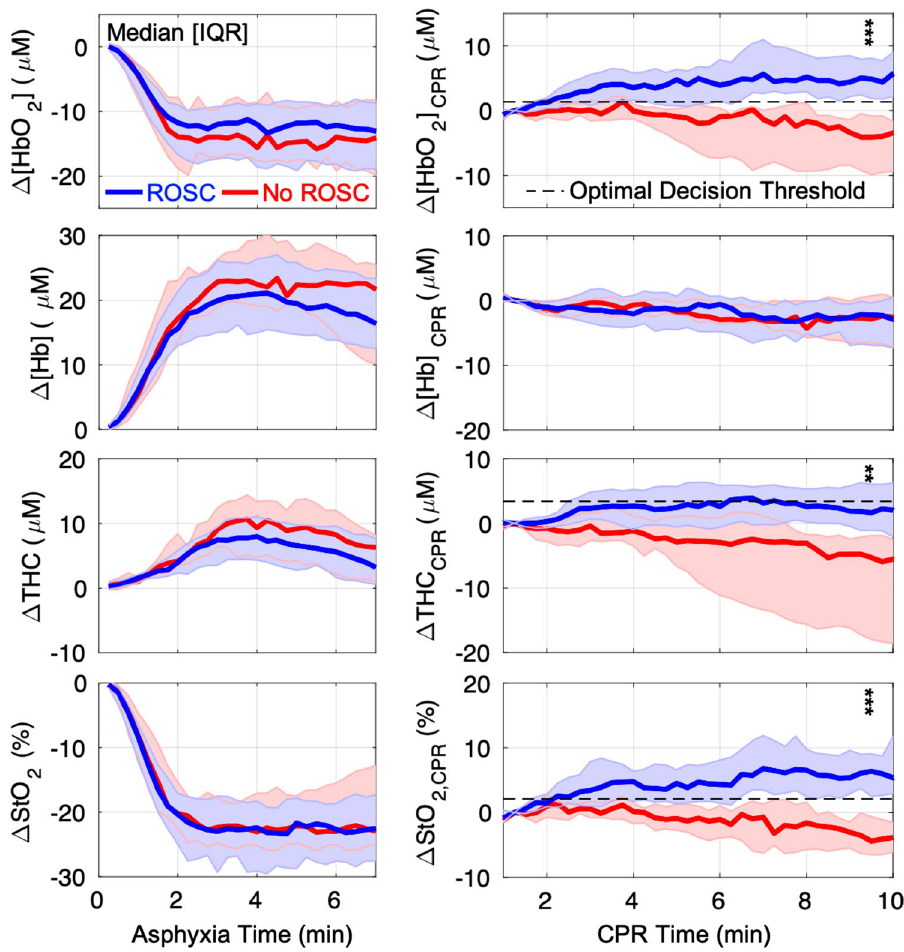
Figure 3. Changes in Cerebral Hemodynamics during Asphyxia and CPR: The changes in cerebral oxy- hemoglobin concentration (Δ[HbO 2 ]; first row ), deoxy-hemoglobin concentration (Δ[Hb]; second row ), total hemoglobin concentration (ΔTHC; third row ) and tissue oxygen saturation (ΔStO 2 ; bottom row ) from baseline during asphyxia ( left ), and from 1-min of CPR during CPR ( right ), are summarized and grouped by CPR outcome (ROSC, blue ; No ROSC, red ). Data are plotted as median ( thick solid line ) and interquartile range (IQR; thin solid line ). The optimal decision threshold for ROSC are also plotted (dotted line) for Δ[HbO 2 ] CPR (+ 1.3 µmol/L), ΔTHC CPR (+ 3.4 µmol/L), and ΔStO 2,CPR (+ 2.1%). In the 10th minute of CPR, association with ROSC was assessed by Wilcoxon Rank-Sum test (**, p < 0.01; ***, p <